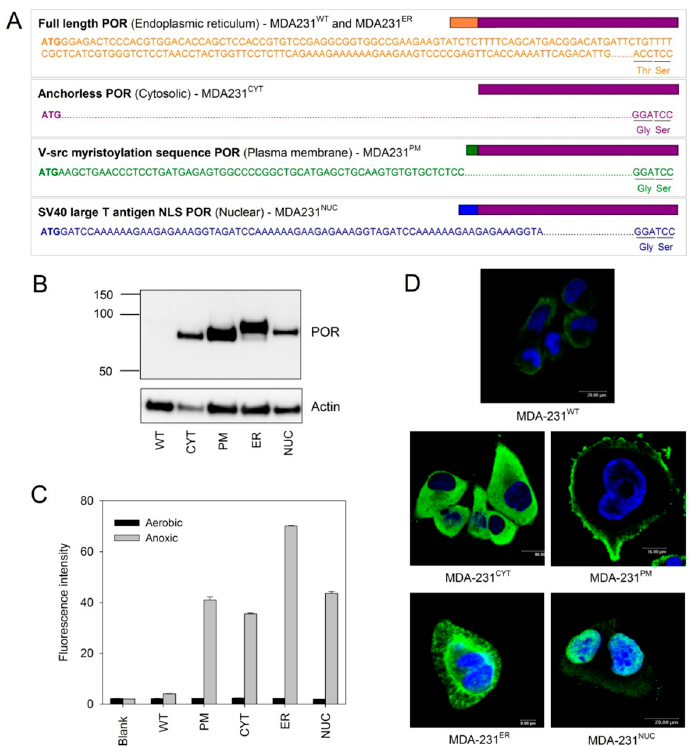
Figure 2. Generation of clonal MDA-231 cell lines expressing POR in di ff erent subcellular locations: ( A ) Details of the localization sequences used to direct POR to di ff erent subcellular compartments; ( B ) Western blot analysis showing expression levels and size di ff erences of POR in the transfected cell lines; ( C ) Flow cytometry detection of POR enzyme activity in the transfected cell lines with an oxygen-sensitive fluorogenic POR substrate (FSL61). Results are the median fluorescence intensity of triplicate samples ± SEM. Blank is cell-free control; ( D ) Immunofluorescence microscopy showing the location of POR expression (green) in the MDA-231 cell lines. Nuclei are stained blue (Hoechst